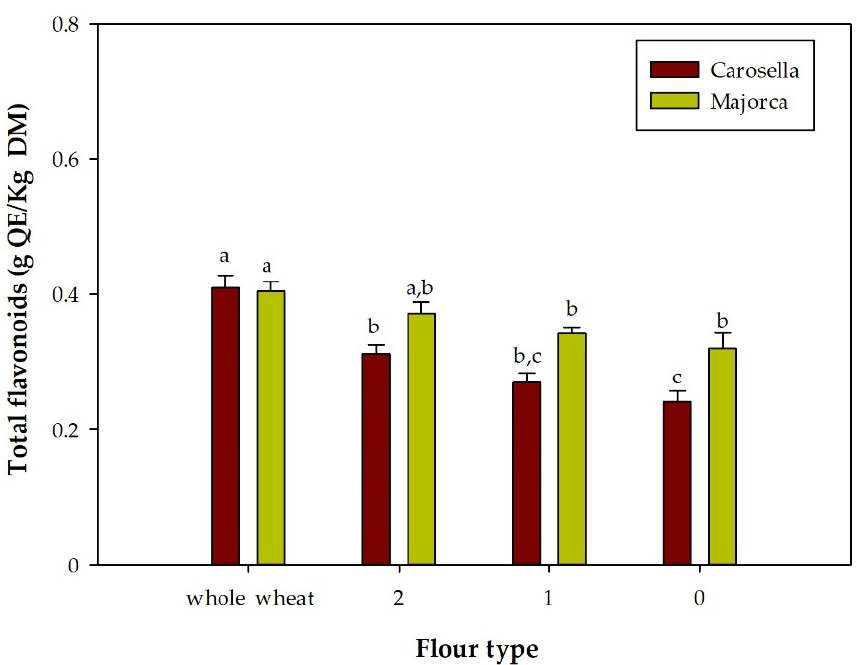
Figure 3. Total flavonoid content of Carosella and Majorca samples. Data are expressed as means ± SD ( n = 3). Different letters indicate statistically significant differences (Bonferroni post hoc test, p < 0.05).